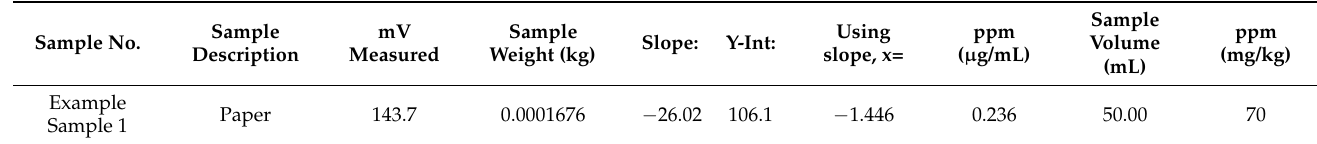
Table 4. Recommended layout of calibration curve ad sample values for reference. E.g., processed data results.